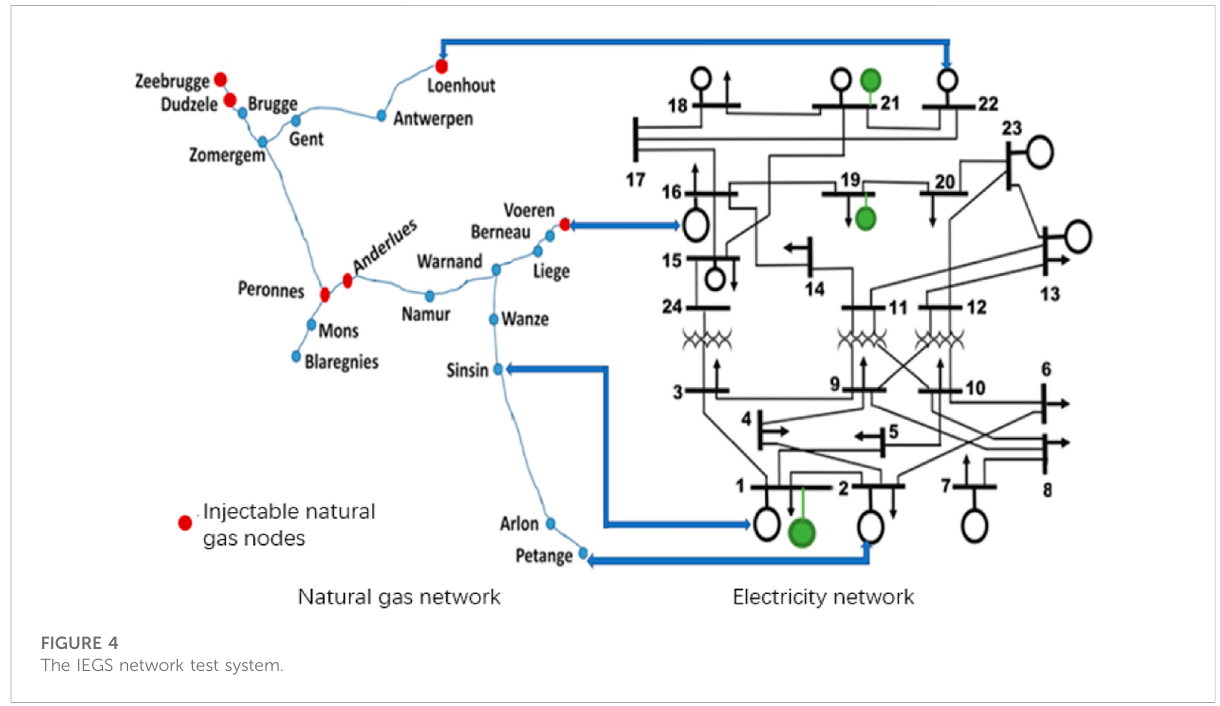
FIGURE 4 The IEGS network test